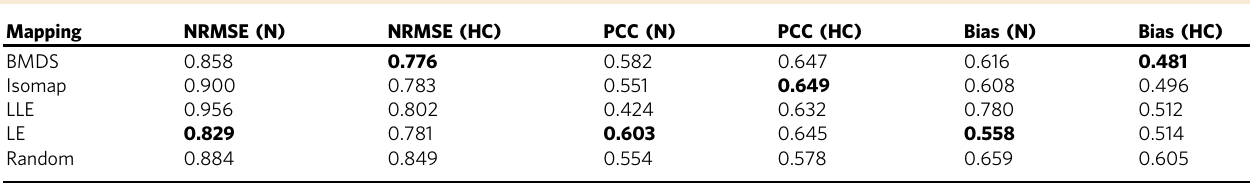
Table 4 Ablation study for REFINED using regression on NCI60 dataset.